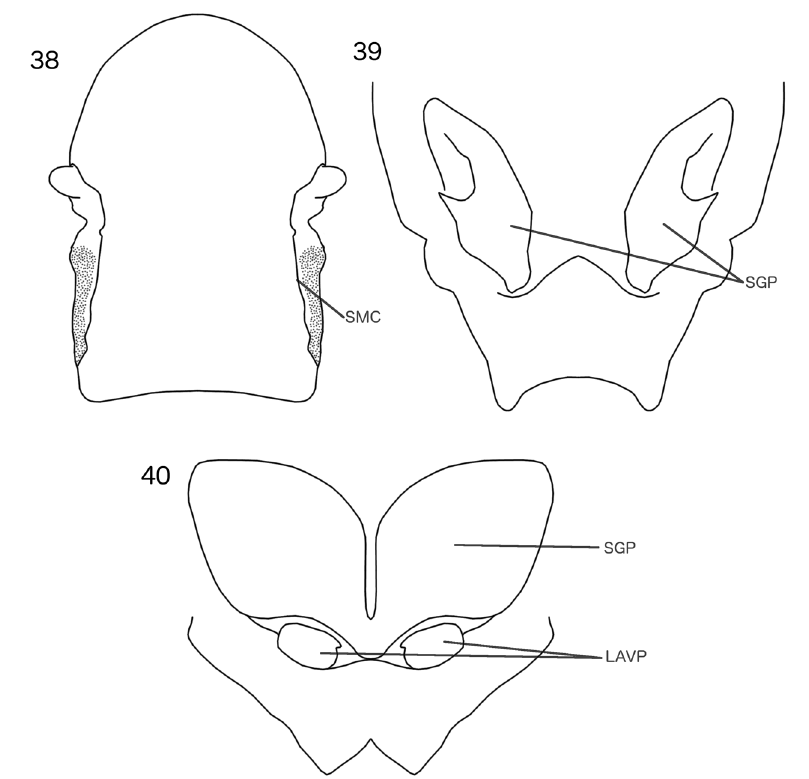
Figs 38–40. 38 . Outline of male head of Valimia polytrapezius (Burmeister, 1838), with post-antennal ventral carina and densely reticulated area marked with grey dots; other characters omitted. 39 . Outline of ventral view of female terminalia of “Oxylipeurus polytrapezius ” (Burmeister, 1838). Setae not illustrated. (38–39 redrawn from Gustafsson & Zou 2020b) 40 . Outline of ventral view of female terminalia of Cataphractomimus impervius Gustafsson et al ., 2020, redrawn and simplified from the original description. Antennae not included in any illustration. Abbreviations used: LAVP = lateral accessory vulval plates; SGP = subgenital plate; SMC = secondary marginal carina. Illustrations are not to